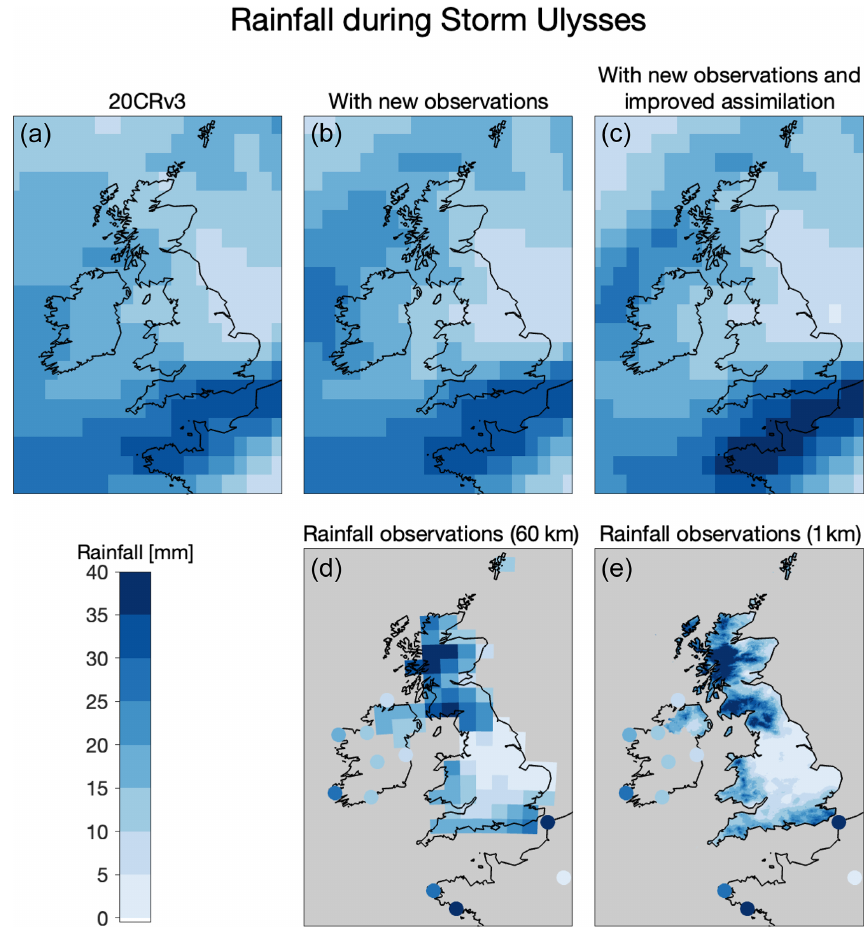
Figure 7. Assessing rainfall variations during the storm. Rainfall in millimetres for the 48h period between 09:00UTC on 26 February and 09:00UTC on 28 February 1903 in the three versions of the reanalysis (a–c) , compared with gridded rainfall reconstructions for the UK, interpolated from in situ observations (HadUK-Grid, on two different spatial scales; d, e ). The 60km dataset roughly matches the spatial resolution of 20CRv3. Other available individual station rainfall observations for Ireland and France are shown with filled circles (see Appendix A). None of the rainfall data are assimilated in the reanalyses, and so the observational data and reanalysis output are